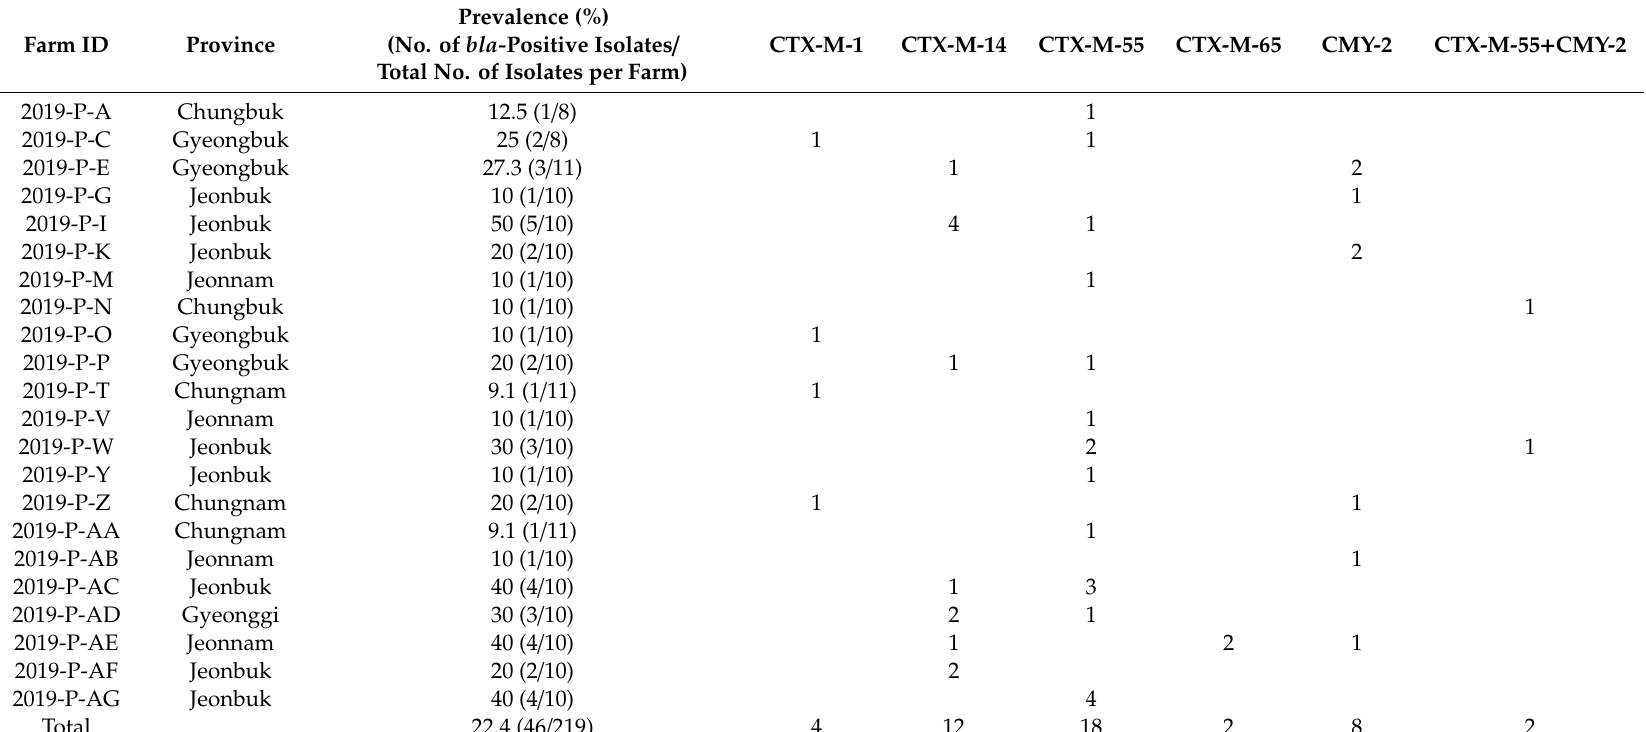
Table 3. Distribution of bla CTX-M and bla CMY-2 -carrying Escherichia coli isolates in broiler chicken farms in